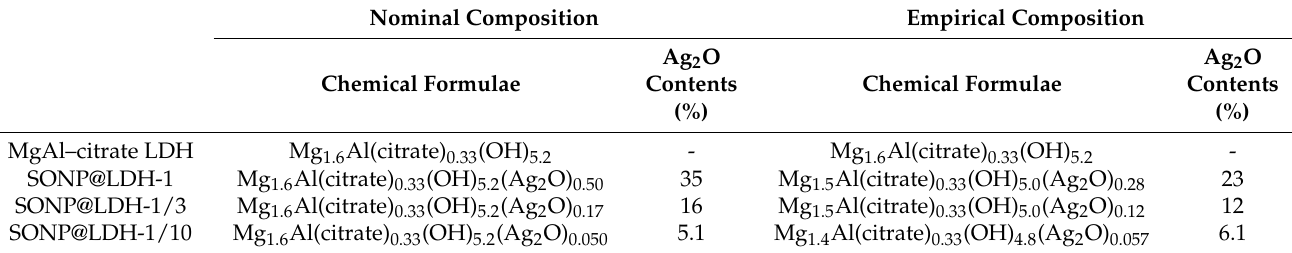
Table 1. Chemical formulae of pristine MgAl–citrate LDH, SONP@LDH-1, SONP@LDH-1/3 and SONP@LDH-1/10. Nominal composition was calculated by hypothesizing all Ag + participated in SONP production. Empirical composition was the quantitative analysis results from